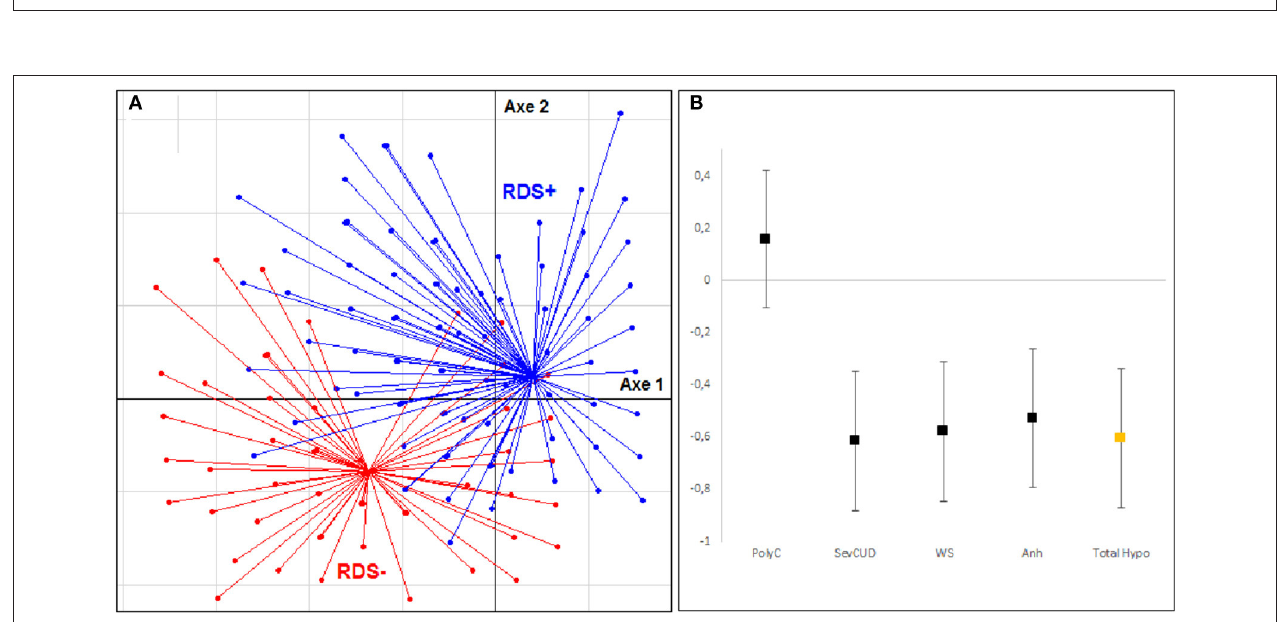
FIGURE 2 | Multidimensional factor analysis and effect size for hypodopaminergic components. (A) Tridimensional representation of the distribution of subjects with and without depressive symptoms during cocaine withdrawal (RDS– group in Red, RDS + group in Blue) according to clinical variables of hypodopaminergia: severity of dependence (SevCUD), withdrawal symptoms (WS), anhedonia (Anh), polyconsumption (PolyC). (B) Hedges’ effect-size of each variable for the hypodopaminergic components.